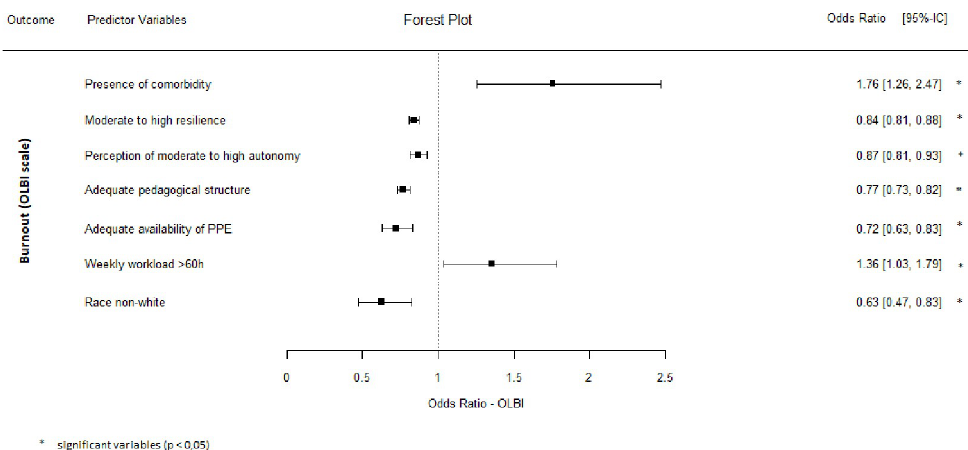
Fig 1. Multivariate logistic regression analysis of predictors associated with burnout (OLBI) among health residents.